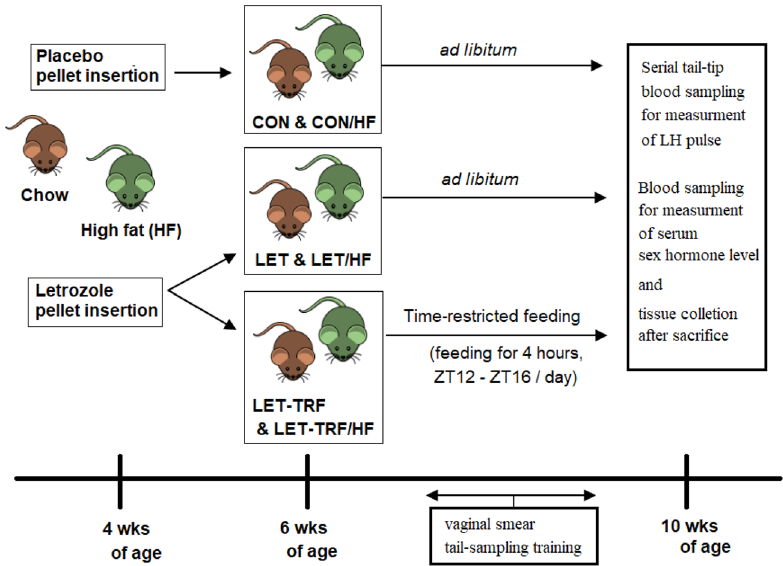
Figure 1. Experimental design of the study. C57BL/6 female mice were implanted with pellets containing letrozole or placebo at four weeks of age. At six weeks of age, half of the letrozole-treated mice continued ad libitum, while the other half started time-restricted feeding. Consequently, three groups were created: CON, LET, and LET-TRF. Body weights were measured twice per week throughout the study period. Vaginal smears were taken from 8 weeks of age to 10 weeks of age to assess the estrous cycle stage. Serial tail-tip blood sampling was performed to measure LH pulse at 10 weeks of age after 2–3 weeks of training for those procedures. The mice were euthanized at the end of the experiment, and tissues and serum were collected for analysis. All experiments were divided into CHOW diet and 60% HFD groups according to the type of diet fed to the mice. CON control, LET letrozole-treated, HF , high-fat diet, wk